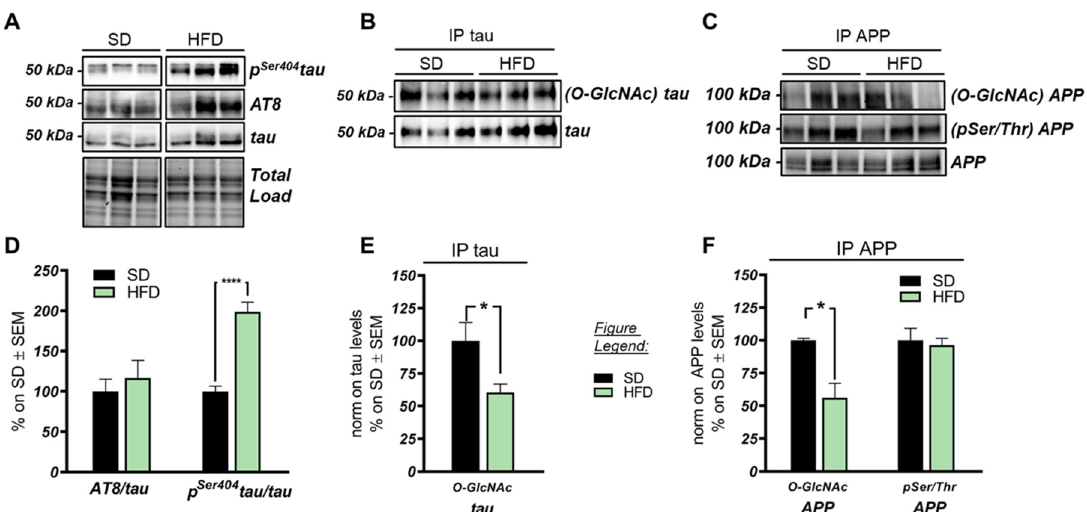
Figure 4. Role of altered protein O-GlcNAcylation in the onset of Alzheimer’s disease (AD) hallmarks in the brain of HFD mice. ( A,D ): Analysis of tau phosphorylation status in HFD hippocampus compared to SD-fed animals. A trend of increase was observed in Ser202-Thr205 tau/tau (AT8), together with a significant increase in Ser404 tau/tau that was observed in HFD mice compared to respective controls. Representative blots are reported in ( A ). ( B , E ) Evaluation of O-GlcNAc tau levels by immunoprecipitation analysis. O-GlcNAc tau/tau levels were remarkably reduced in the hippocampi of HFD mice in comparison to SD mice. Representative blots are reported in ( B ). ( C , F ) Evaluation of O-GlcNAc APP and pSer/Thr APP levels by immunoprecipitation analysis. O-GlcNAc APP/APP was significantly reduced in HFD mice in comparison to SD animals, not supported by an inverse increase in its phosphorylated levels. Representative blots are reported in ( C ). Number of animals for each condition were as follow: n = 6/group for Western blot analysis, while n = 3/group was used for immunoprecipitation analysis. All bar charts reported in ( D ) and ( E , F ) show mean ± SEM. * p < 0.05, **** p < 0.0001 using Student’s t test.